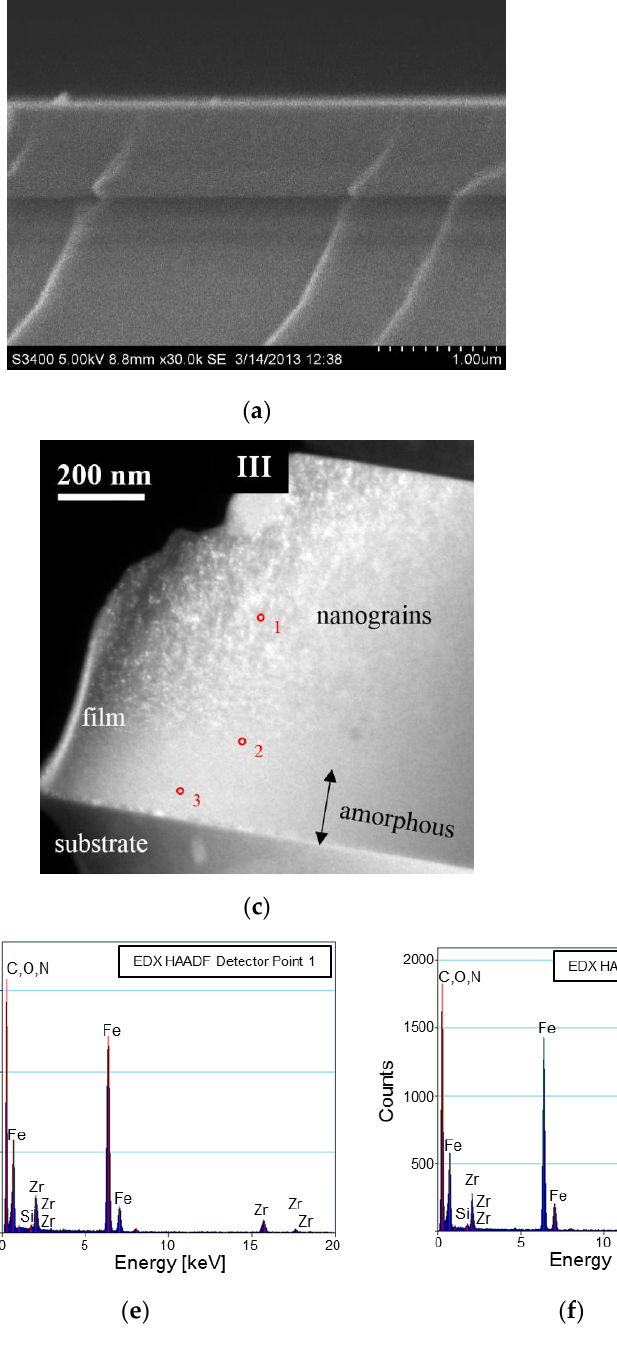
Figure 1. The SEM cross-sectional image ( a ) and the GDOES profile of the distribution of the elements in depth ( b ) of the as-deposited film III. The dark-field TEM images of a cross-section of the films III with an equiaxial grain orientation ( c ) and IV with a columnar structure ( d ). The red dots 1, 2, 3 in the micrograph ( c ) correspond to the EDX spectra ( e – g ).